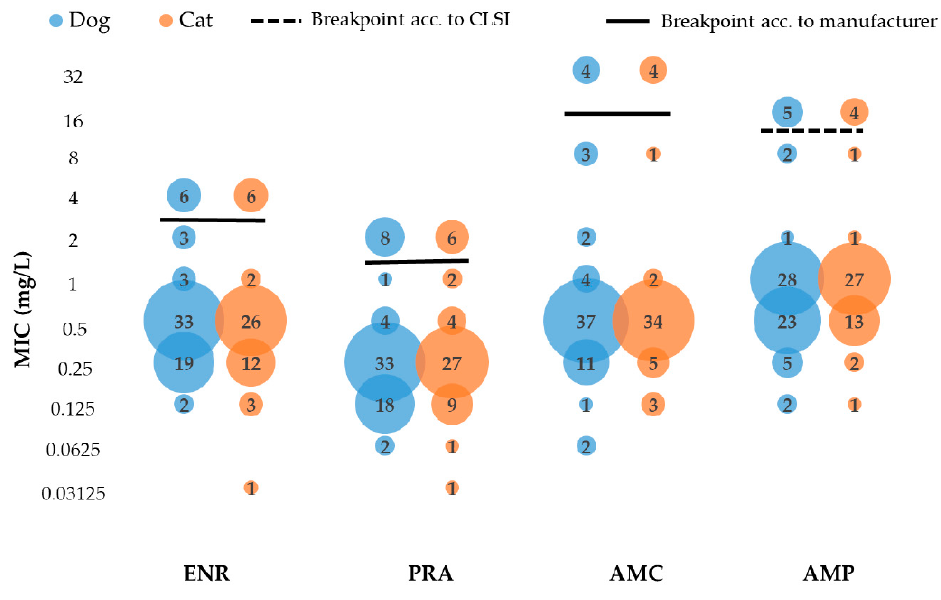
Figure 3. Distribution of MIC data of 66 canine and 50 feline enterococci for the antimicrobials ENR, PRA, AMC, and AMP. acc. = according.